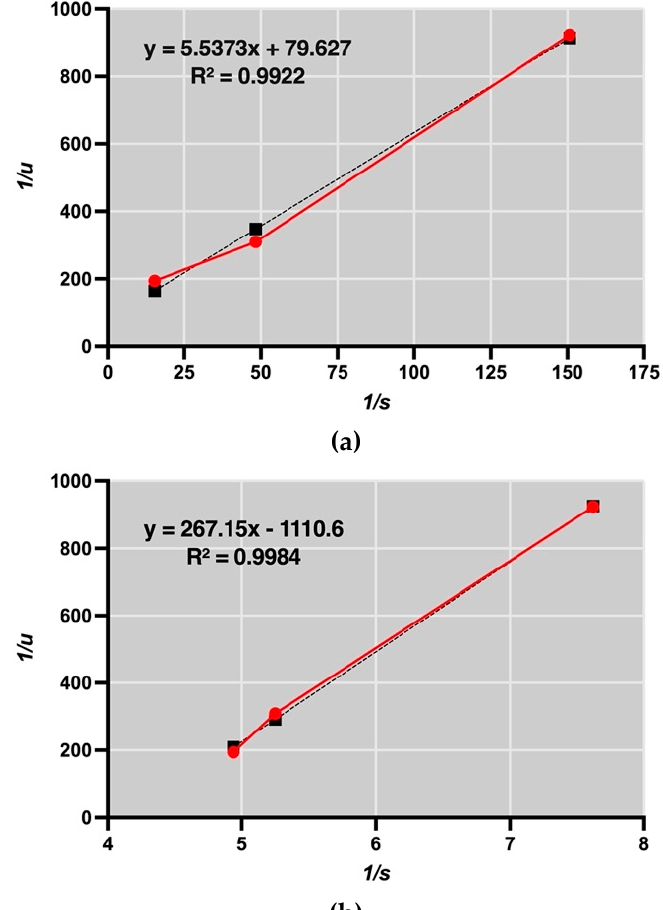
Figure 2. Consumption constant rates for NO 3 ( a ) and PO 4 ( b ).